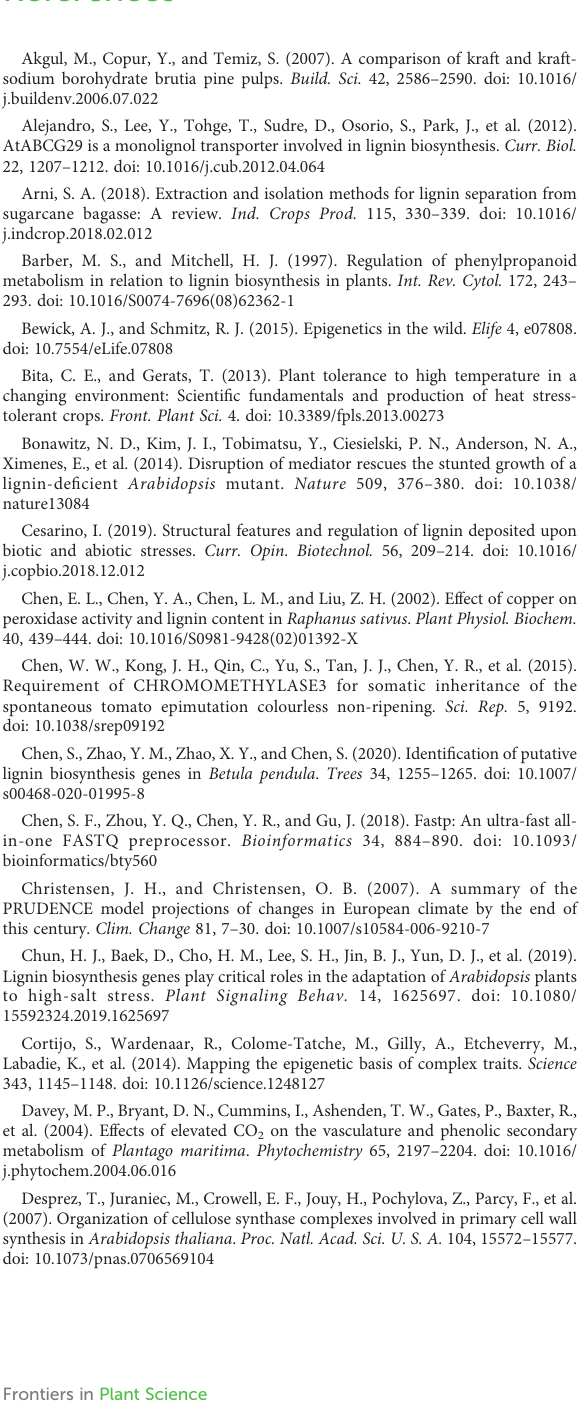
Ame, and Alh. The t -test was used to evaluate the difference in genes expression between the Sl, Fhs and Ame, Alh. The p ≤ 0.01 is marked as ‘ ** ’ , p ≤ 0.001 is marked as ‘ *** ’ , and p > 0.05 is marked as ‘ n.s ’ . SUPPLEMENTARY FIGURE 13 Transcript level of BpCsl s in birch. (A) Phylogenetic analysis of Csls of birch and Arabidopsis . The rooted neighbor-joining (NJ) phylogenetic tree of Csls was clustered with bootstrap values shown for each clade in circles with a different size. Birch genes with black circle outside is for the candidate genes that most probably encode Csls in birch. (B) Transcript pattern of BpCsl s in Sl, Fhs, Ame, and